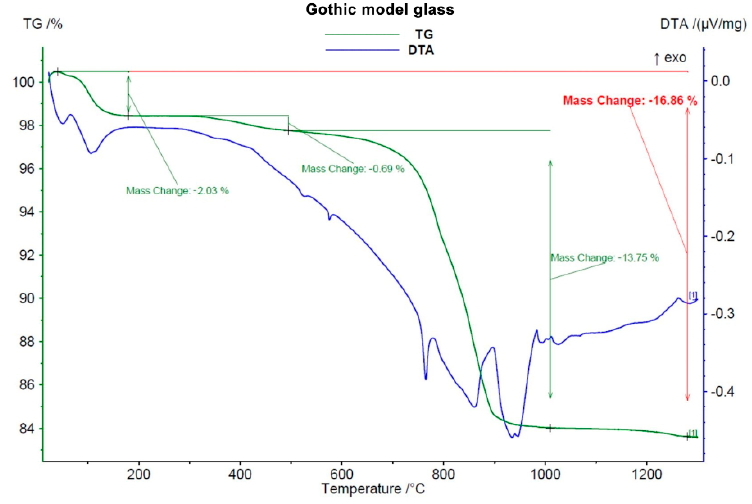
Figure 1. Course of DTA-TG analysis of Gothic model glass.